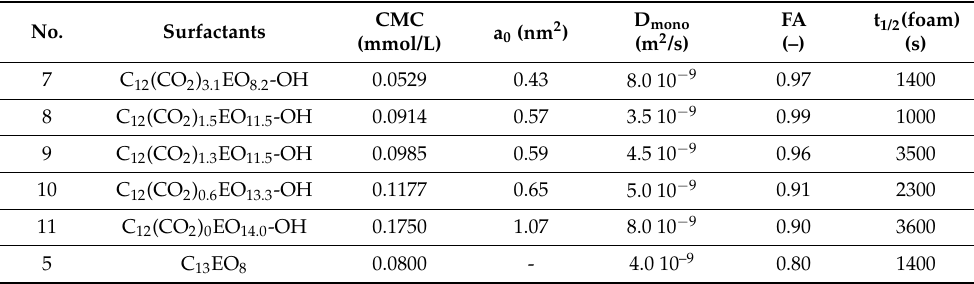
Table 5. Quantification of the foaming behavior of the carbonate-modified nonionic surfactants for a correlation with their physical properties Adapted with permission from Ref. [20], 2023, Elsevier. The CMC and headgroup area a o were obtained from the static-surface-tension data. The FA was calculated from Equation